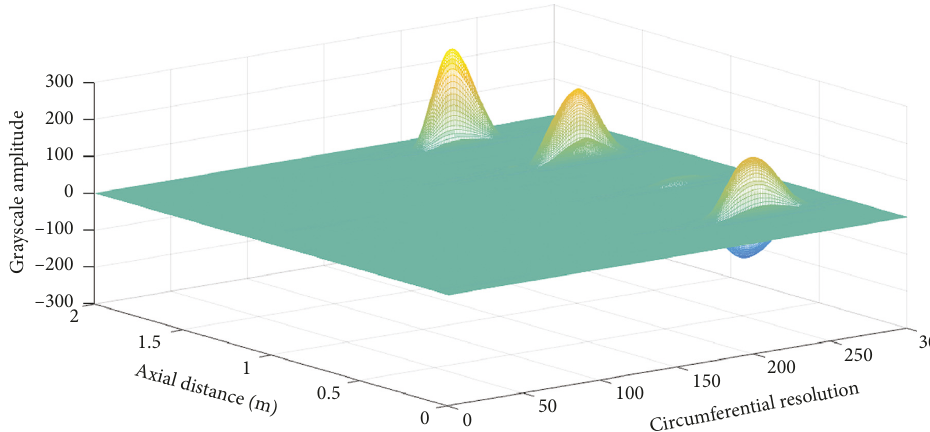
Figure 9: Graph of MFL data after interpolation.